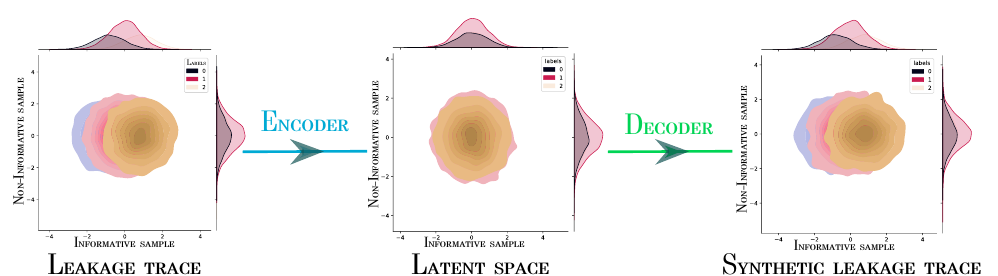
Figure 6: Evolution of the distributions over the cVAE-SA model when a successful attack is performed ( F 9 ).